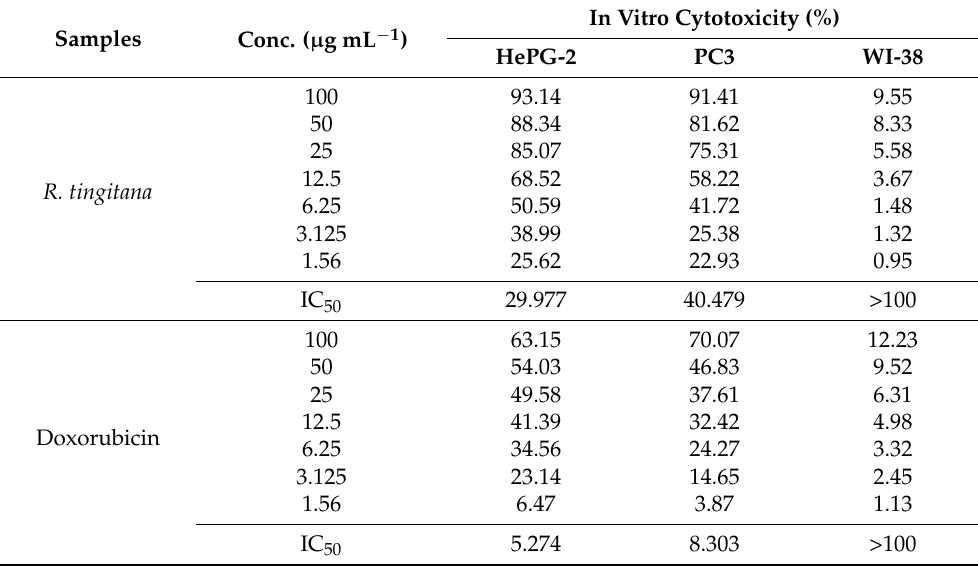
Table 4. Cytotoxic activity and the IC 50 values of the R. tingitana MeOH extract against the tumor and normal cells at different concentrations, and doxorubicin as standard. Hepatocellular carcinoma (HePG-2), human prostate cancer (PC3), and normal cell (WI-38). In Vitro Cytotoxicity (%) Samples Conc. ( µ g mL − 1 ) HePG-2 PC3 WI-38 100